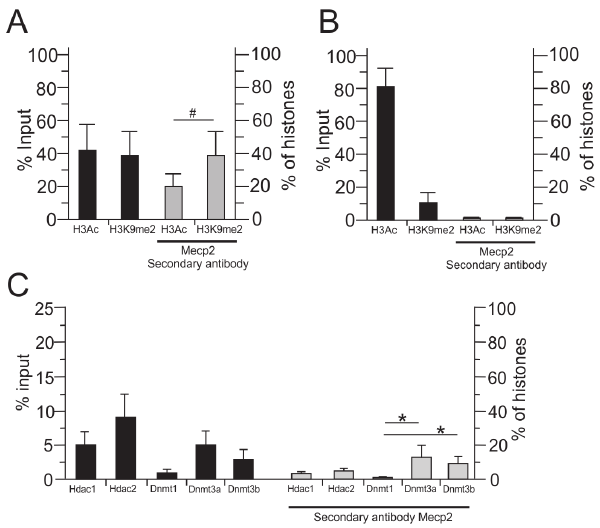
Figure 7. Mecp2 occupancy at the Avp enhancer coupled with repressive chromatin marks and repressor complexes. A,